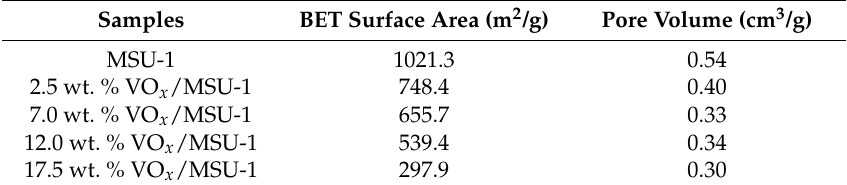
Table 1. Physical properties of MSU-1 and VO x /MSU-1 with different VO x loading. Samples BET Surface Area (m 2